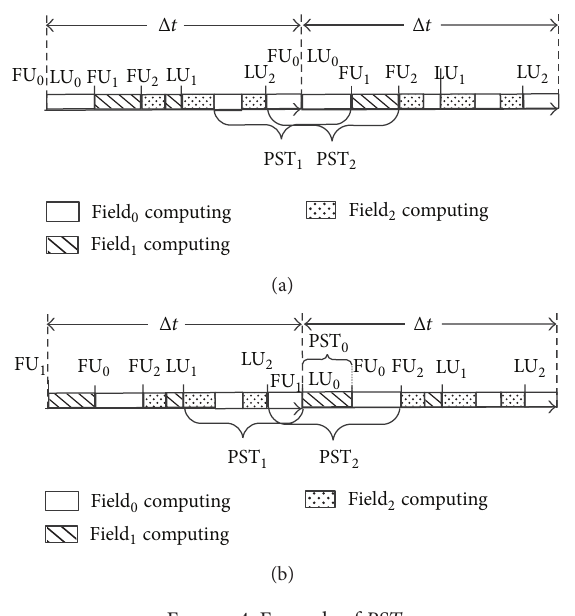
Figure 4: Example of PST